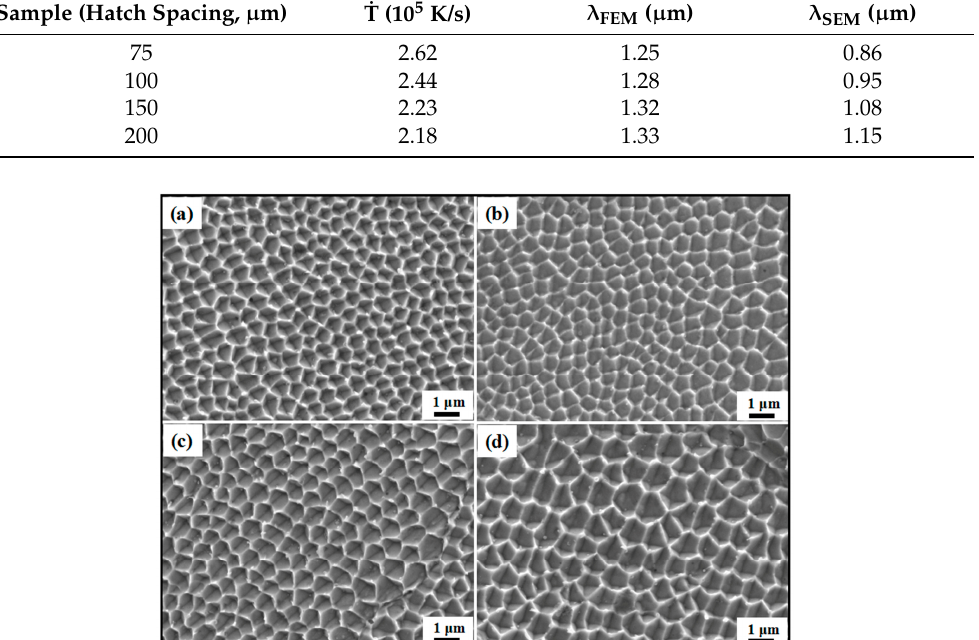
Figure 5. ( a ) FEM temperature-time curve of 316L SS samples simulated based on their optimized parameters and ( b ) its magnified temperature-time curves between the solidus and liquidus for different process parameters.